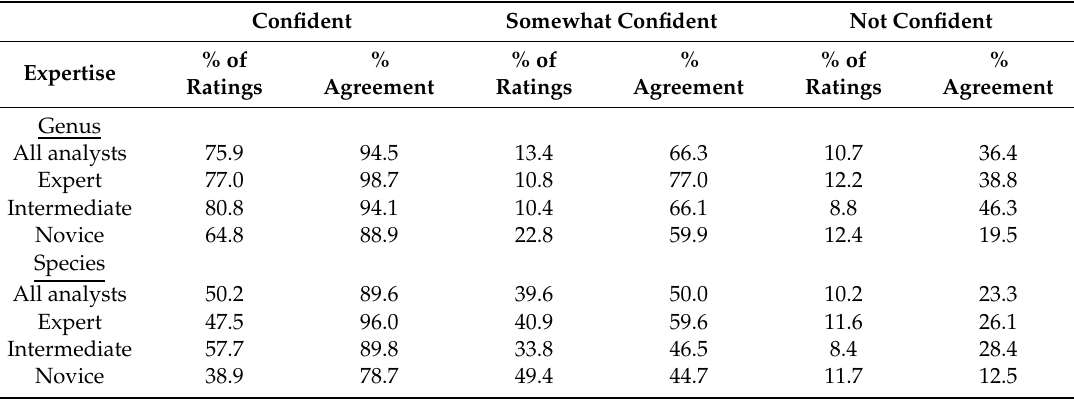
Table 5. Percent of total ratings and percent agreement with field data by confidence level and expertise level for genus and species